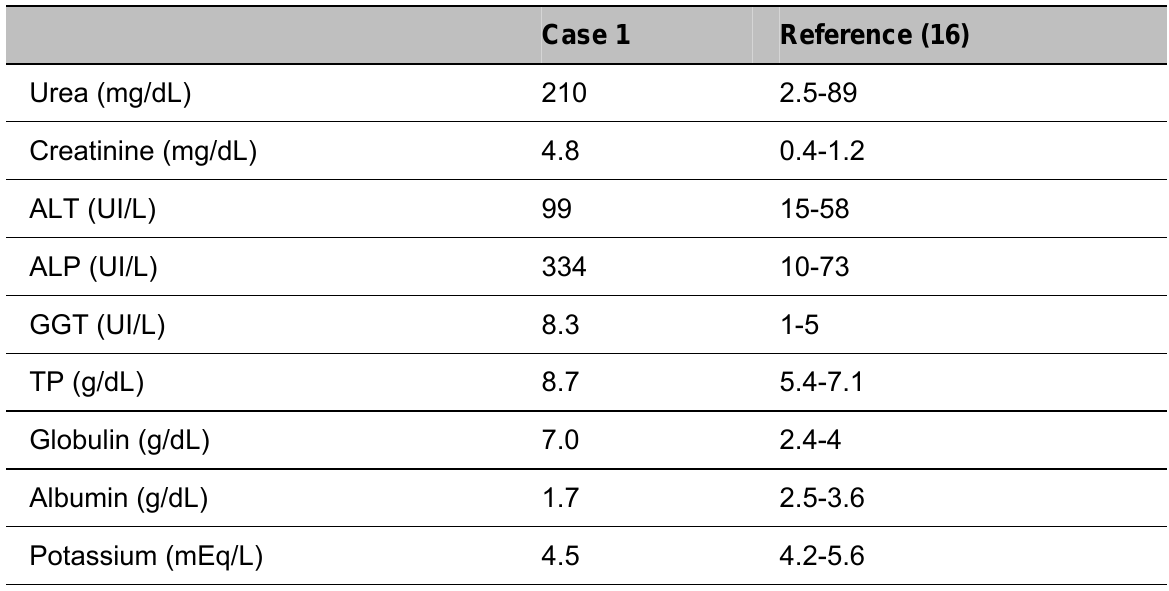
Table 2. Biochemical findings of Case 1 dog poisoned by